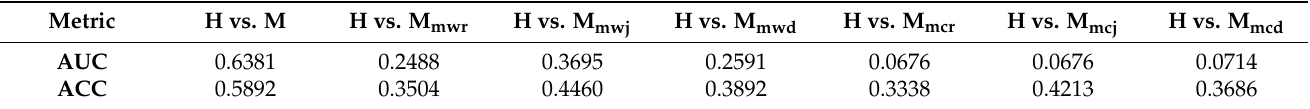
Table 1. Detailed performance of RoBERTa-Base in different classification